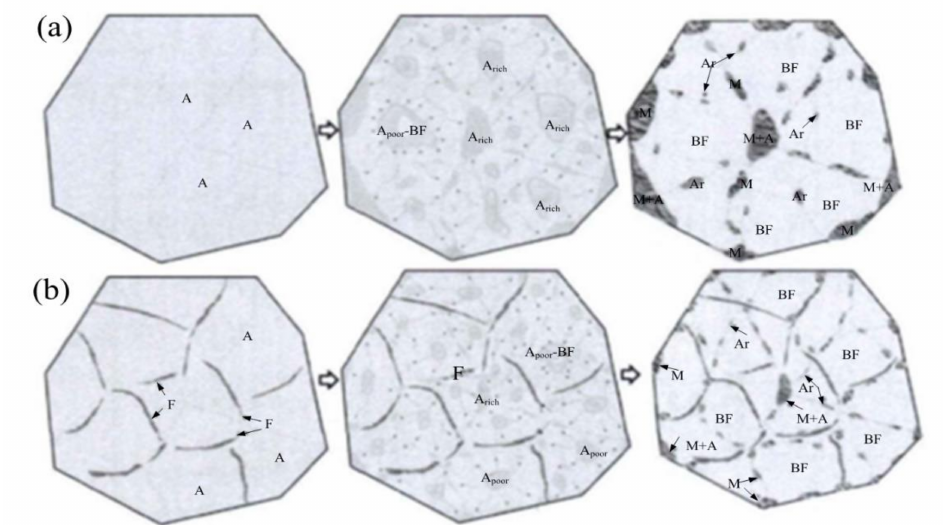
Figure 14. The schematic diagram showing the formation of M − A constituent during granular bainitic transformation ( a ) traditional normalizing process; ( b ) ferrite films formed in the intercritical normalizing process (Where, A: austenite, Arich: rich in composition of C Ni Mn, Apoor: poor in composition of C Ni Mn, BF: bainite ferrite, Ar: retained austenite, M martensite, F: ferrite, and M+A: martensite and